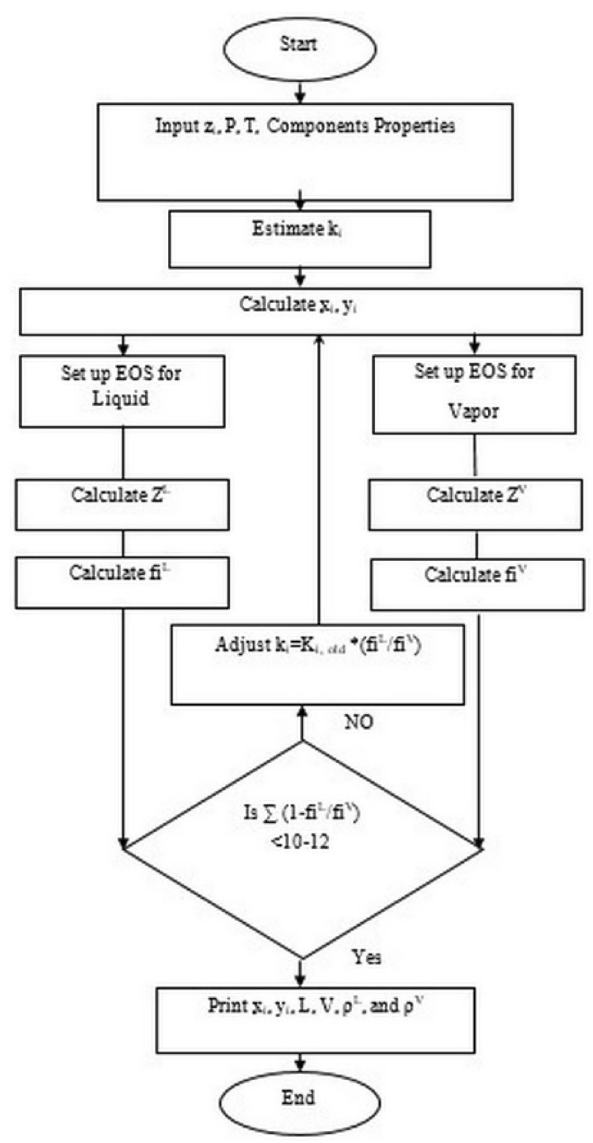
Fig. 1 Iteration method of flash calculation of two-phase flow in equi-